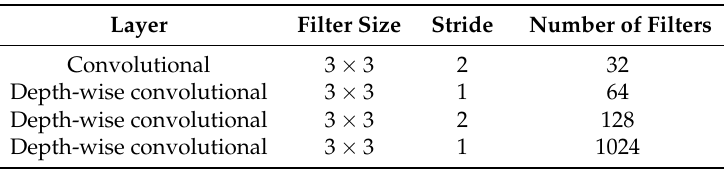
Table 1. Structure of the eye state detection